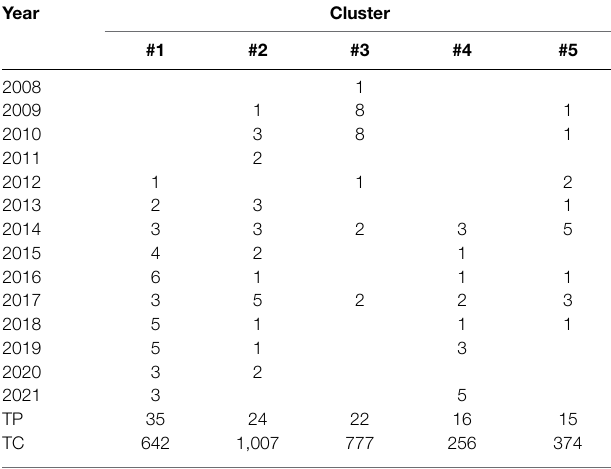
TABLE 7 | Bibliographic coupling network clustering